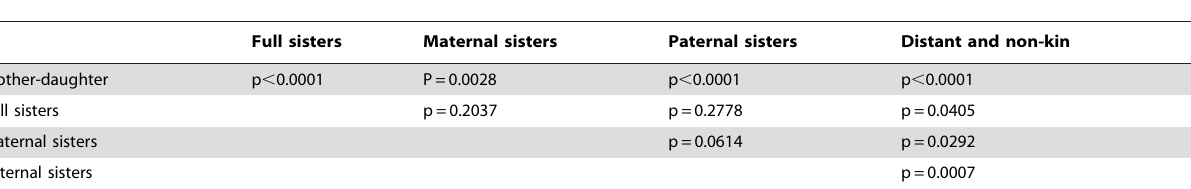
Table 3. Differences in the strength of social bonds (CSI) between kin